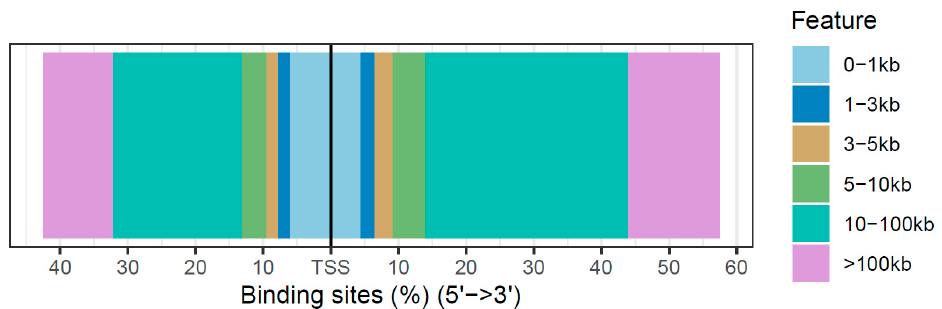
Figure 3. Distribution of transcription-factor-binding loci relative to the TSS of differentially accessible regions (DARs) for weaning.